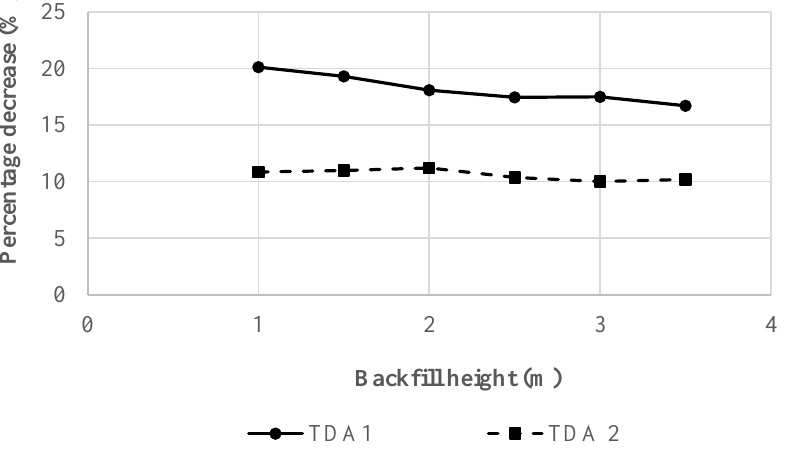
Figure 9. Percentage decrease of the maximum bending moment using TDA 1 and TDA 2 trench configurations for the SW90 backfill.